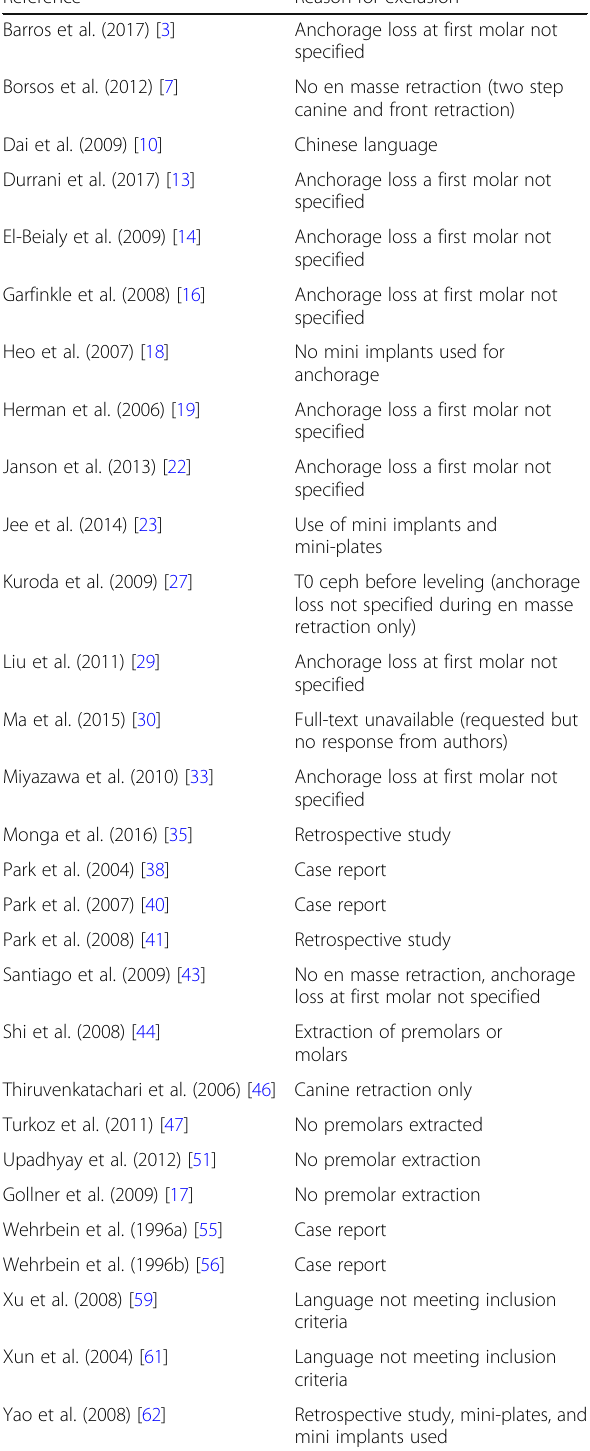
Table 1 List of excluded studies (with